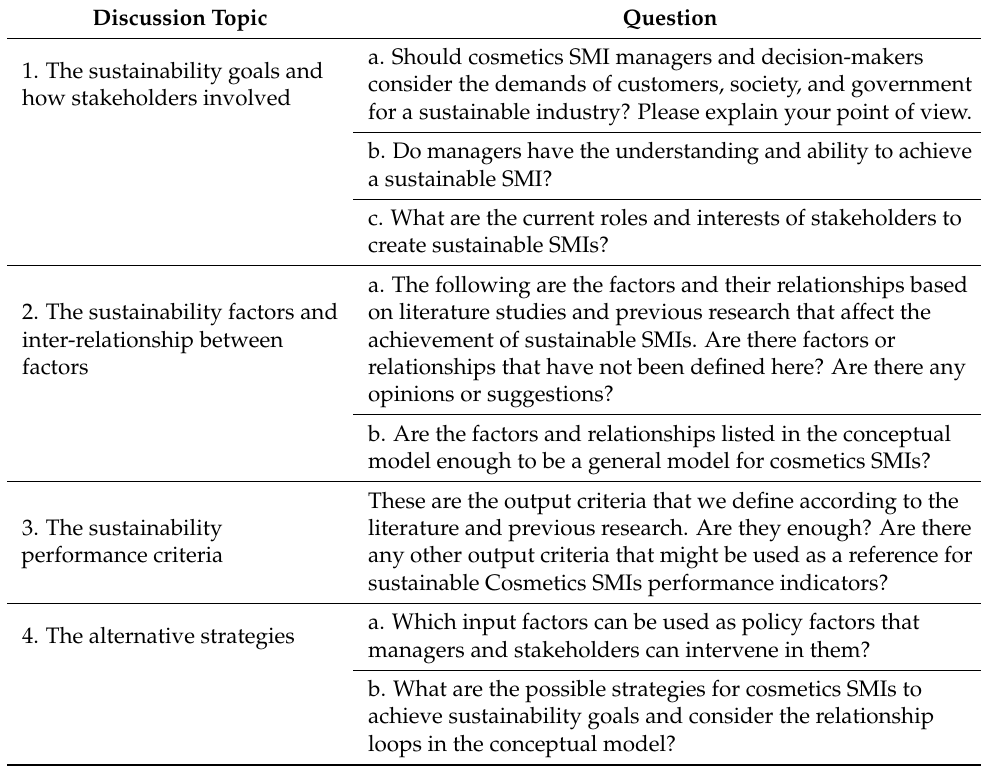
Table A1. The triggered questions for discussion with experts in the Focus Group Discussion (FGD).